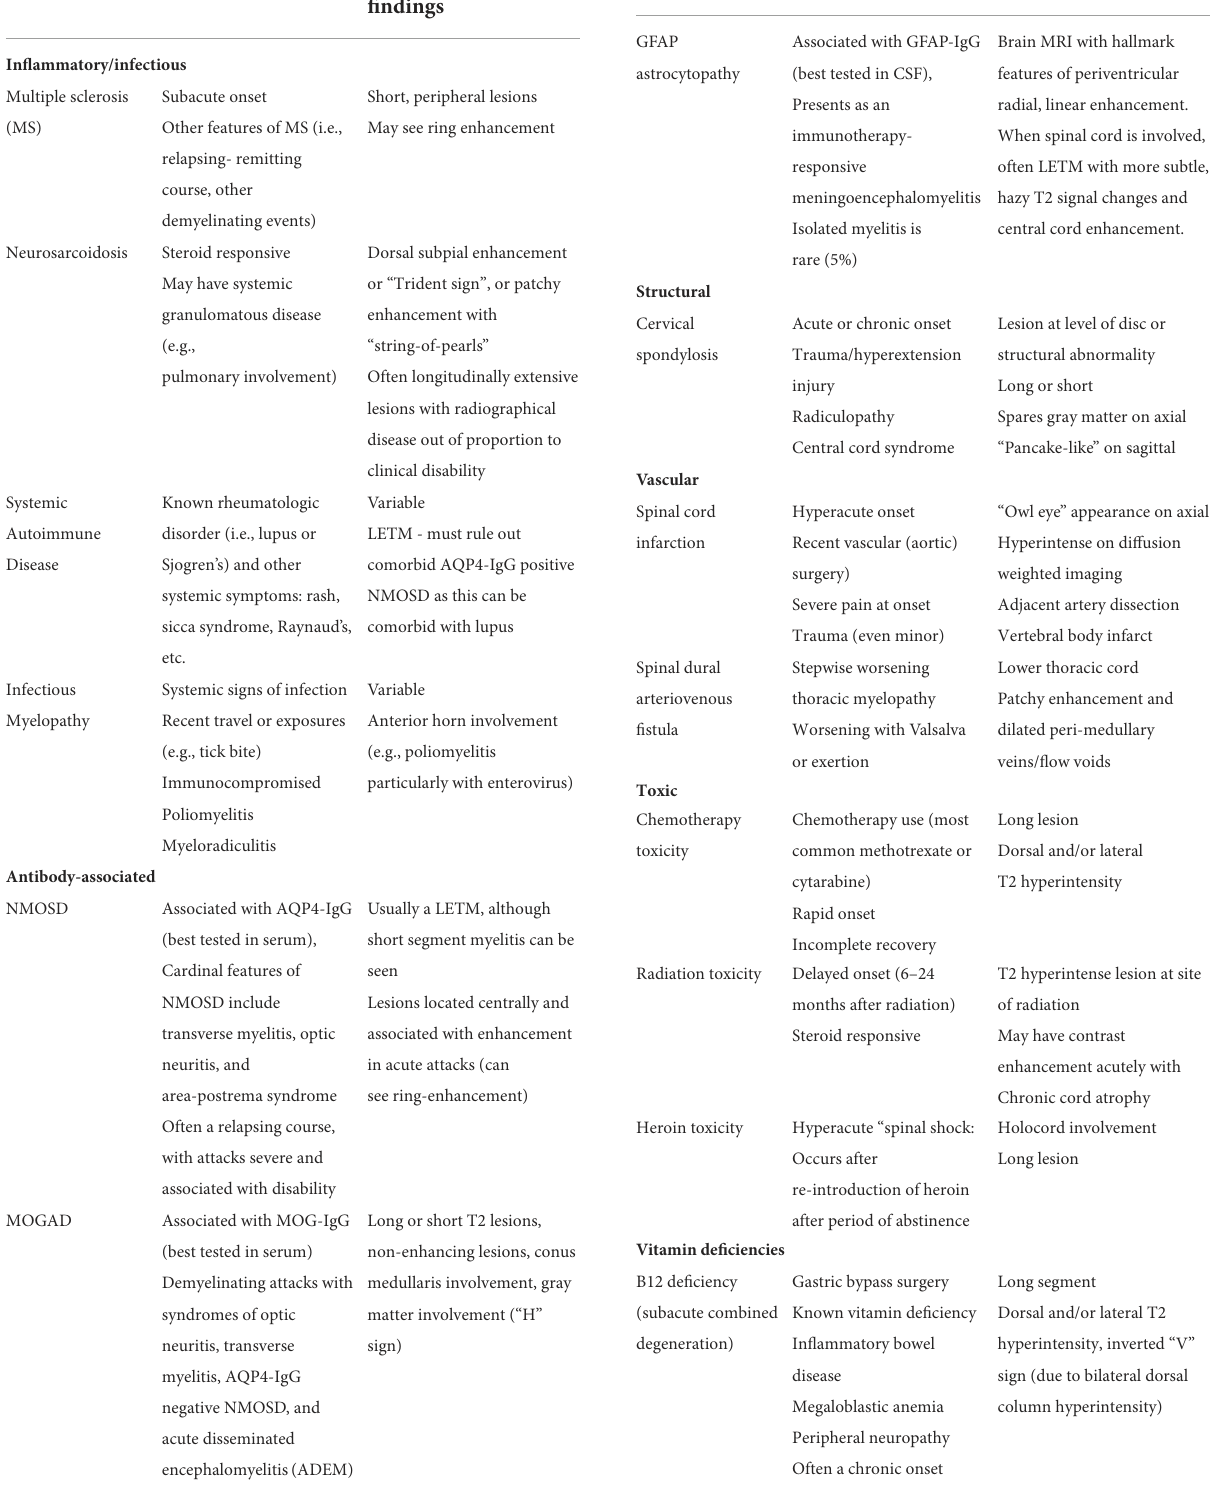
TABLE 1 Differential diagnosis of myelopathies by etiologic classification and associated clinical and radiographical findings.